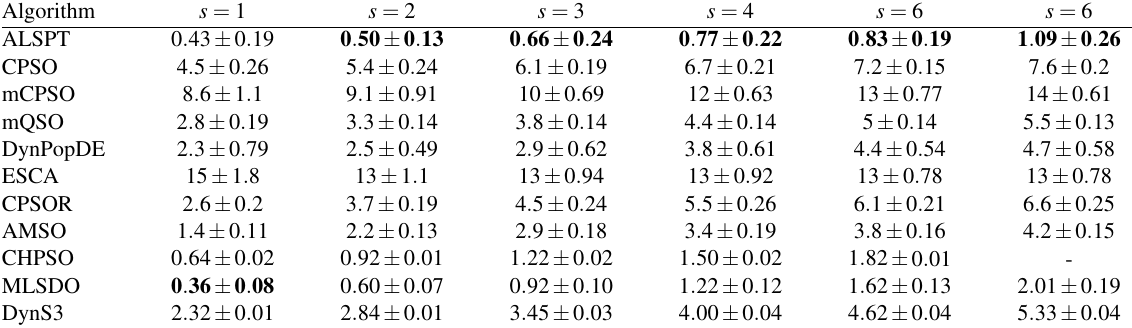
Table 8. e of f and standard deviation obtained by our proposal (ALSPT) and the considered state-of- the-art algorithm in the MPB with different shift severity values ( s = 1 ... 6). Algorithm